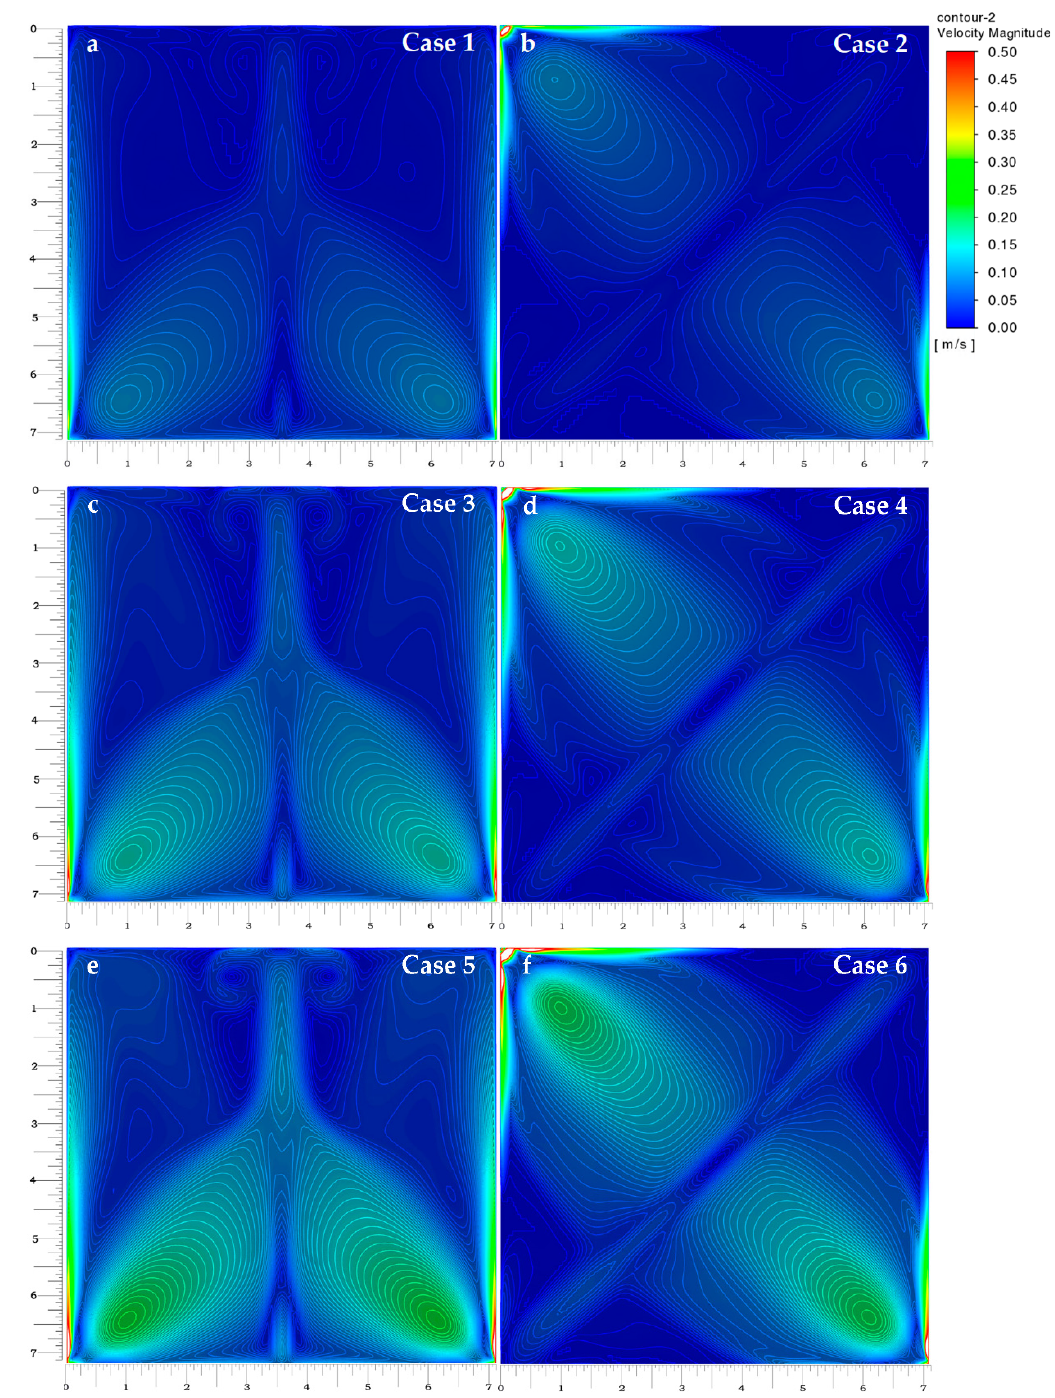
Figure 9. ( a – f ) Show the velocity contour for Cases 1–6 at z = 0.1 m.